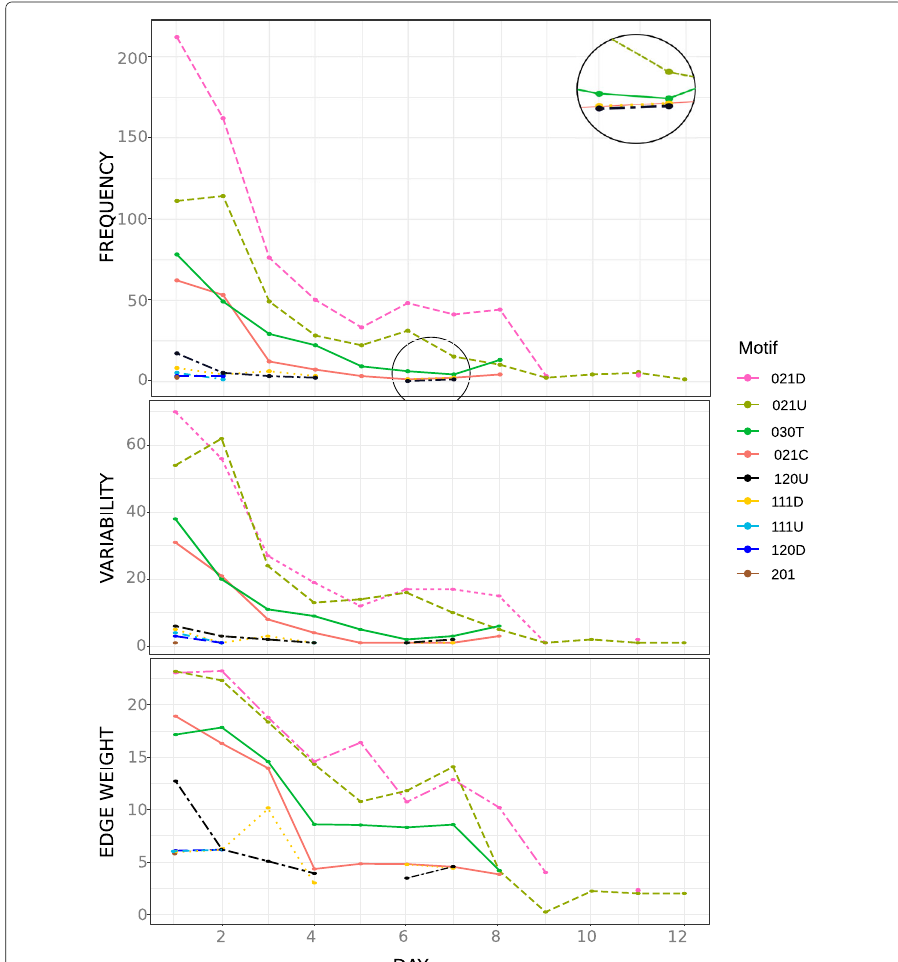
Fig. 8 Daily motif occurrence (motif frequency), variability of its edge distribution, and an average number of edges per motif, aggregated over all